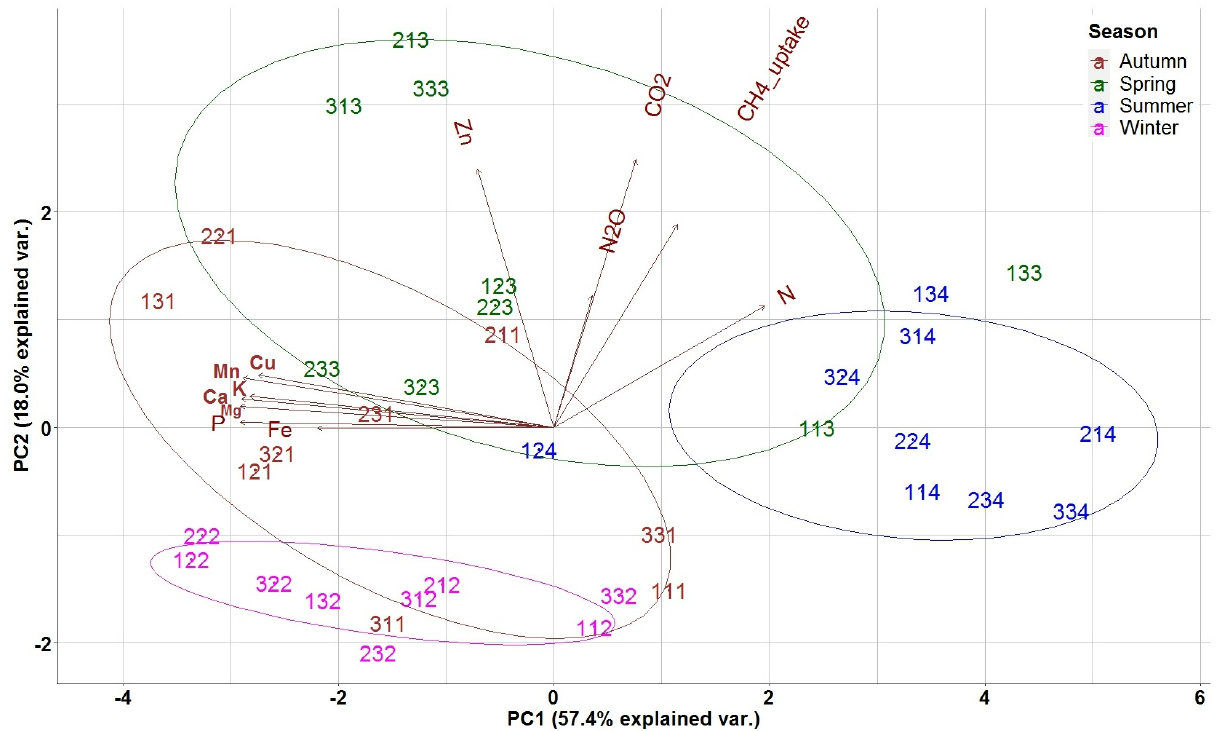
Figure 4. Distribution of nutrients and GHGs in the two first PCA axes for forest floor data. N: